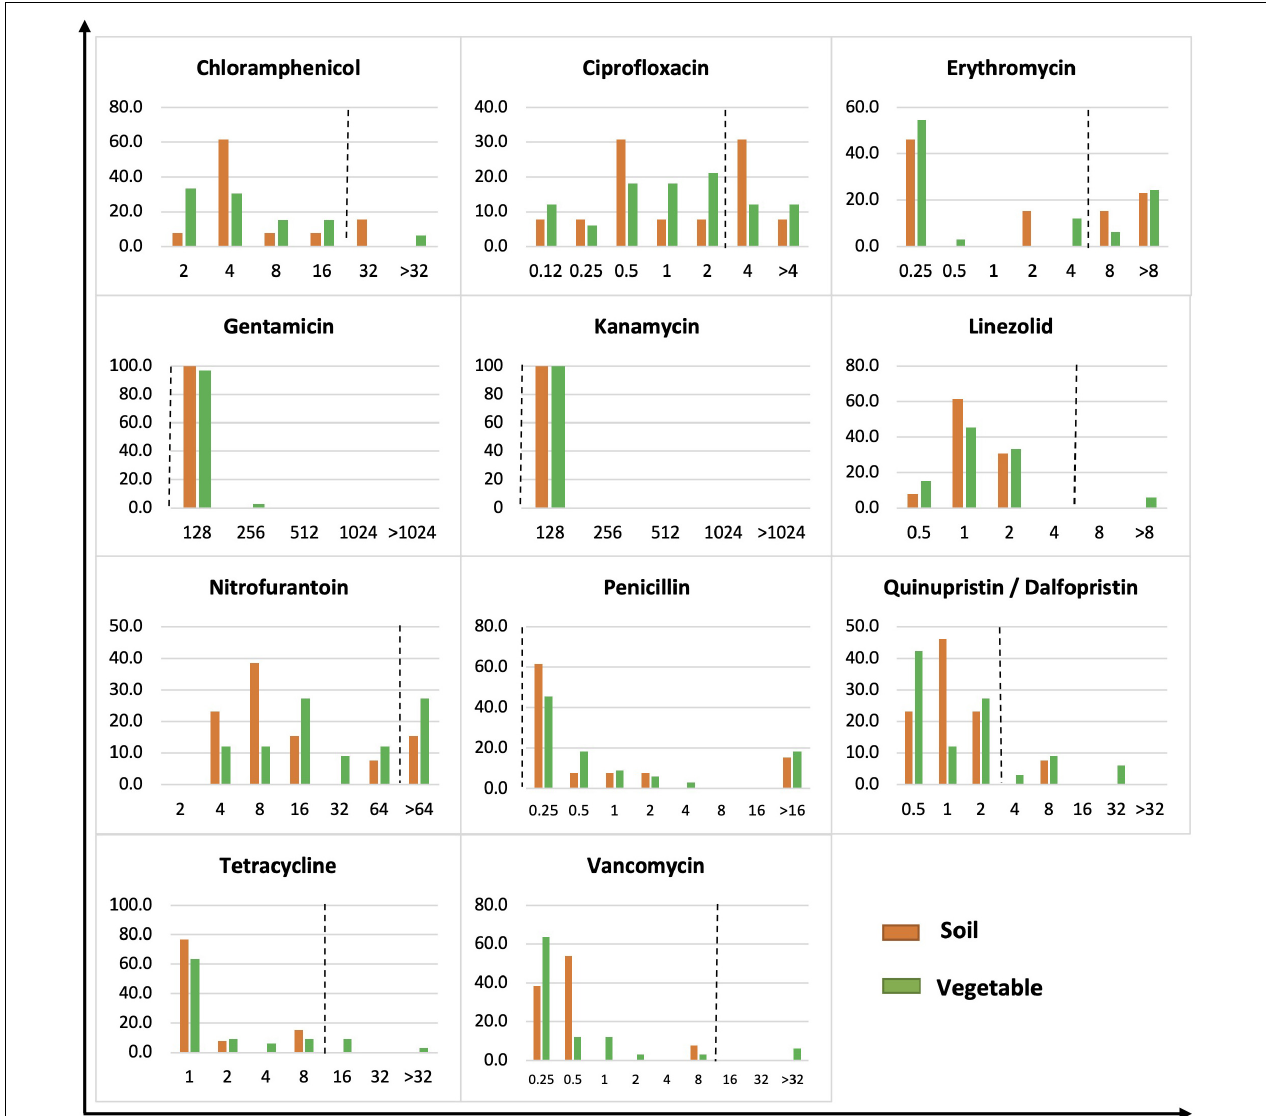
FIGURE 3 | MIC distribution of gram-positive bacteria from soil and vegetable origin. X -axis is MIC in µ g/ml. Y -axis is % of isolates of soil or vegetable isolates. The dot line on each figure stands for the breakpoint of S. aureus against the specific